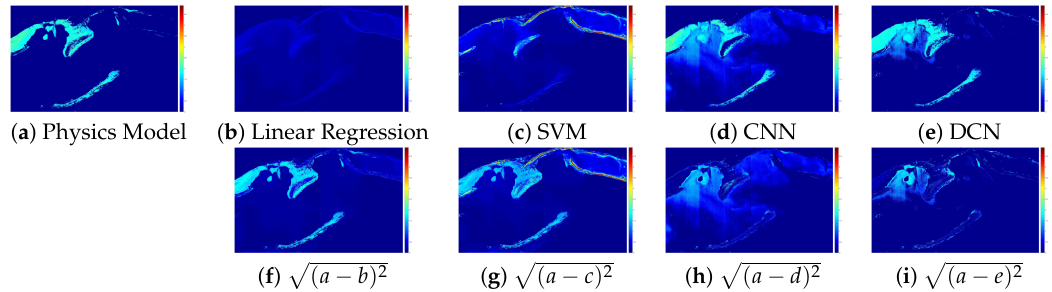
Figure 10. LAI mapping at Saint George Sound produced by models trained with patches from the selected regions. No mask was applied in this